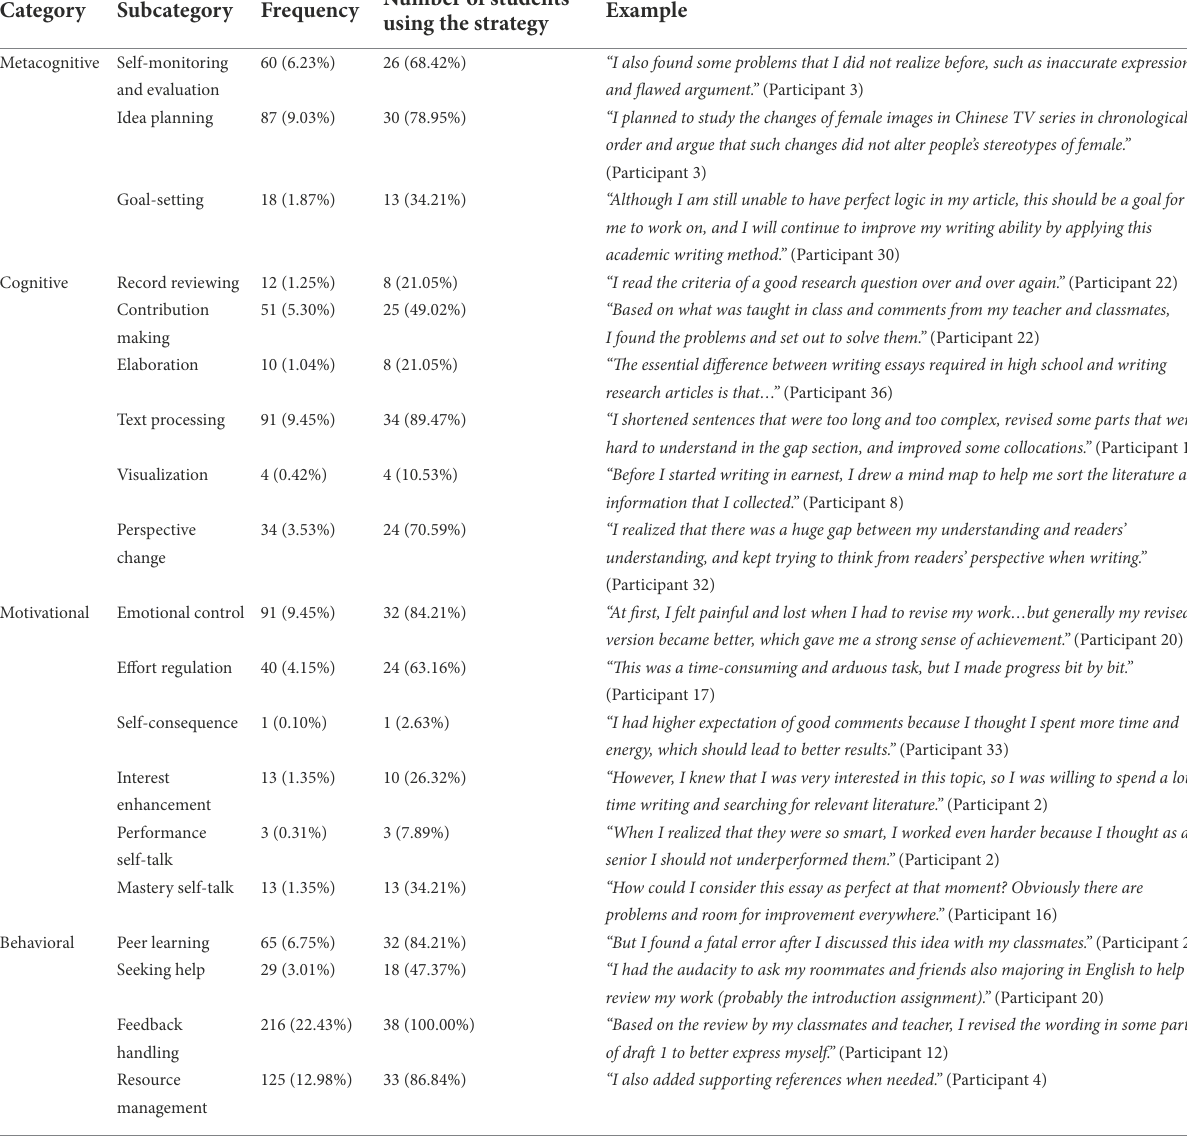
TABLE 3 Overall frequencies of self-regulated writing strategies demonstrated in reflective journals. Category Subcategory Frequency